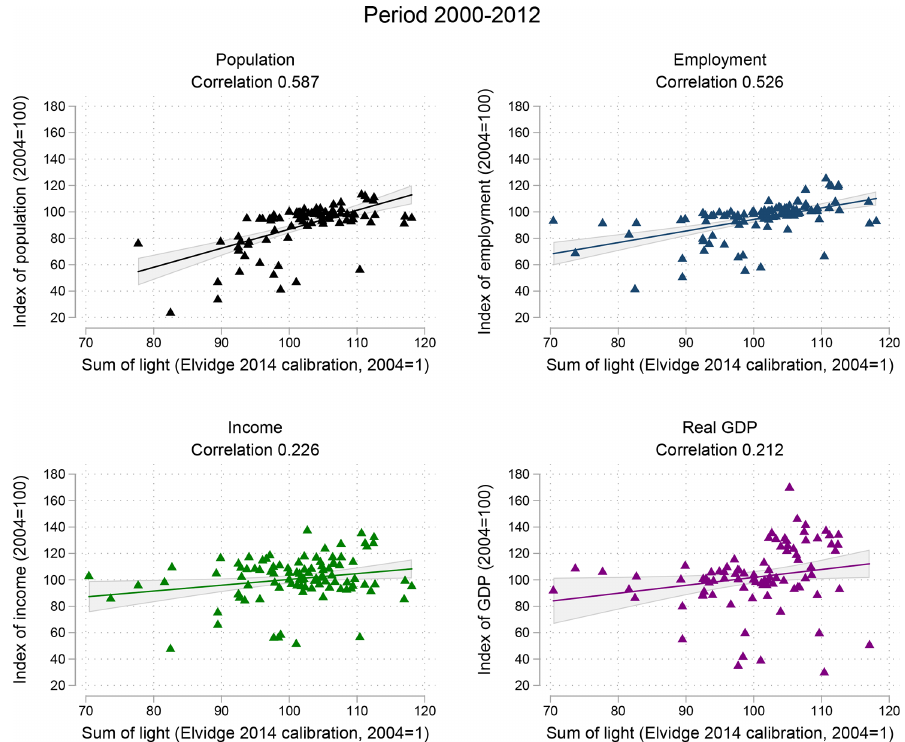
Figure A10. Indexed economic indicators and total sum of light for the eight affected counties after Katrina (2000–2012). Correlations of economic indicators and night lights. Night lights based on Elvidge et al. (2014) calibration, indexed to 2004 = 100. Population data exclude the year